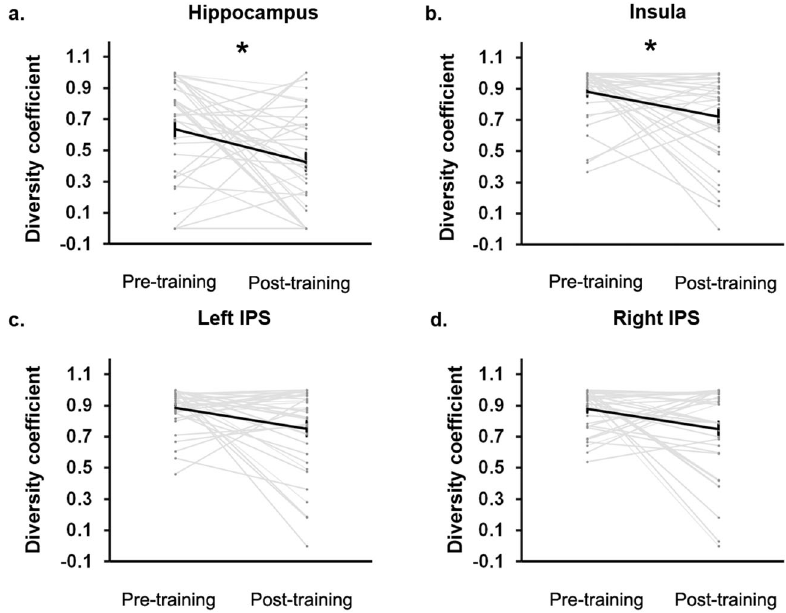
Fig. 5 Cognitive training induces changes in network organization of the hippocampus and anterior insula. Diversity coef fi cient, a measure of how uniformly a brain region interacts with regions in other modules, of ( a ) the right rostral hippocampus and ( b ) the right anterior insula decreased with training ( p s < 0.05, false discovery rate [FDR]-corrected). The diversity coef fi cient of ( c , d ) the bilateral intraparietal sulcus (IPS) — a brain area consistently implicated in numerical problem solving — did not change with training. N = 35 children. Error bar shows standard error of mean. *: p < 0.05.